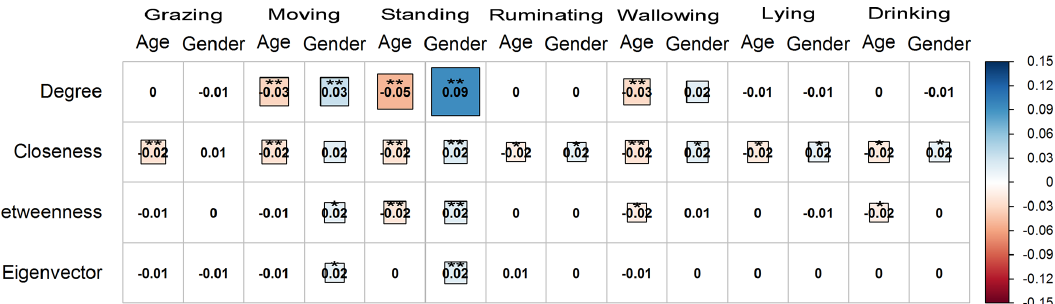
Figure 4. Correlogram presenting the pattern, the strength, and the significance level of Spearman’s rank correlations (two-tailed) between the centralities (degree, closeness, betweenness, and eigenvector) and the attributes age and gender (female = 1, male = 2) of water buffaloes during their activities on pasture (grazing, moving, standing, ruminating, wallowing, lying, and drinking). Red and blue colors represent neg- ative and positive correlation, respectively. Darker colored and bigger square boxes in the panels correspond to higher strength of correlation. Asterisks indicate the statistically significant correlation at P < 0 . 05 ( ∗ ) and P < 0 . 01 ( ∗∗